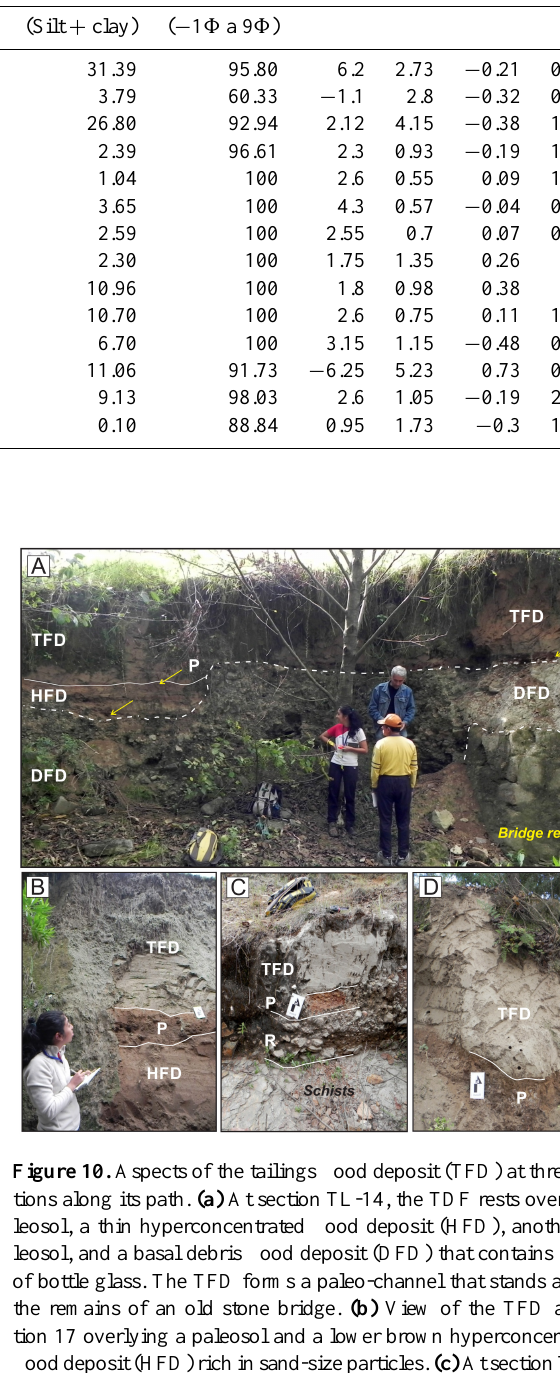
Table 3. Granulometric analyses and statistical parameters of samples collected along the tailings flood deposit. Sample